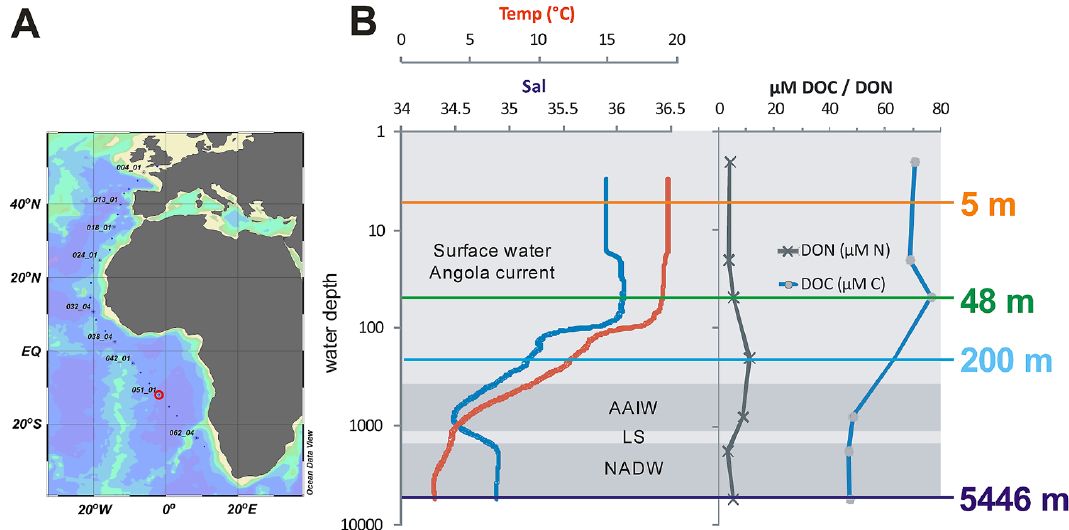
Fig. 1. (A) Sampling location of SPE-DOM during the R/V Polarstern cruise ANTXXV/1 on 27 November 2008 at 3.126 ◦ E, − 17.737 ◦ S; figure courtesy of Gerd Rohardt, AWI. (B) Conditions of oceanic waters; AAIW: Antarctic Intermediate Water, which is derived from the Weddell Sea and Labrador Sea; LS: Labrador Sea (Tomczak and Godfrey, 2003); NADW: Nort Atlantic Deep Water.